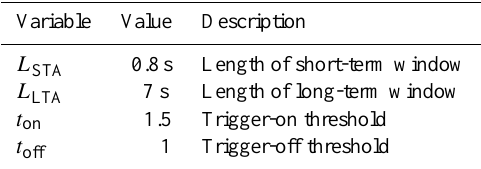
Table A1. STA/LTA parameters used in single-station event detec- tion.